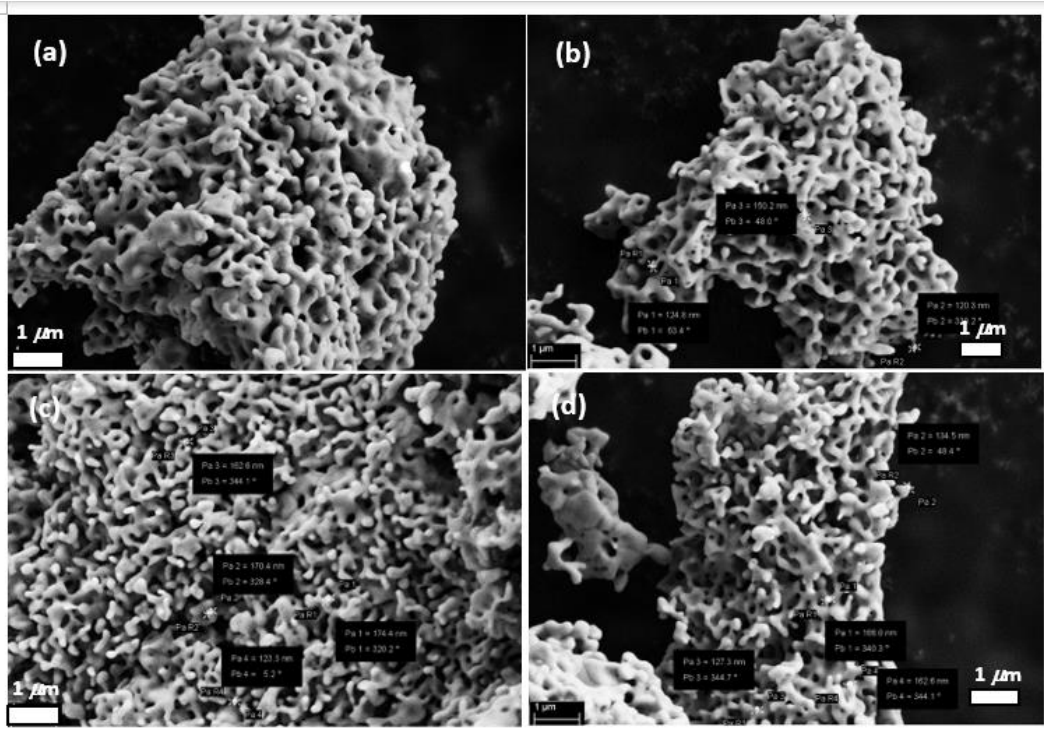
Figure 1. Field mission Scanning Electron Microscope ( FESEM) images for ( a ) YIG, ( b ) La-YIG, ( c ) Nd- YIG and ( d ) Sm-YIG. ( c ) Nd-YIG and ( d )